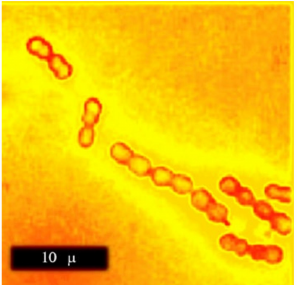
Figure 1. M. elsdenii cells, reproduced from [3] with